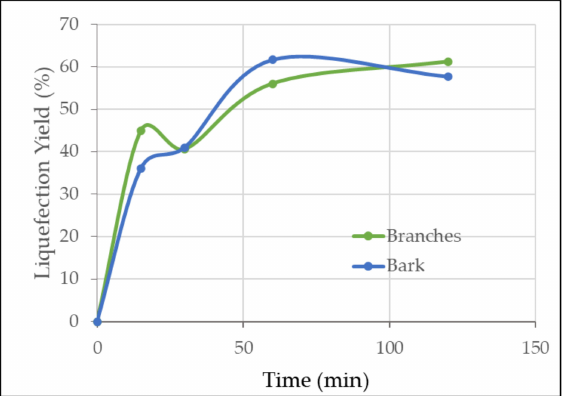
Figure 5. Effect of reaction time on yield of liquefaction products from the fraction of bark and branches particles > 80 mesh (powder) at 180 ◦ C with acid